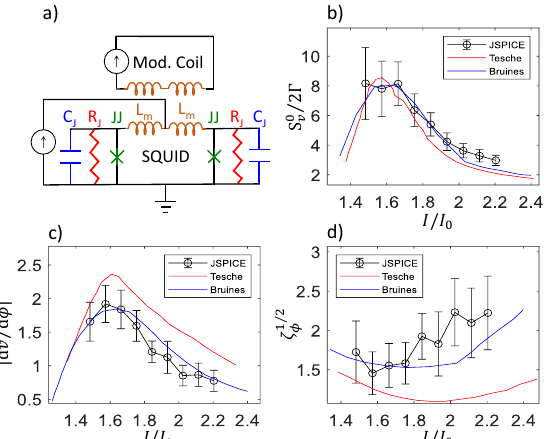
Figure 4. Comparison with previous work: ( a ) Schematic of the model used. In this case, the junction critical current I 0 = 17.2 µ A, junction capacitance C j = 0 pF, modulation inductance L m = 30 pH, shunt resistance R J = 2 Ω , Φ = 0.25 Φ 0 , and T = 20.56 K. This choice of parameters leads to β = 1.0, Γ =